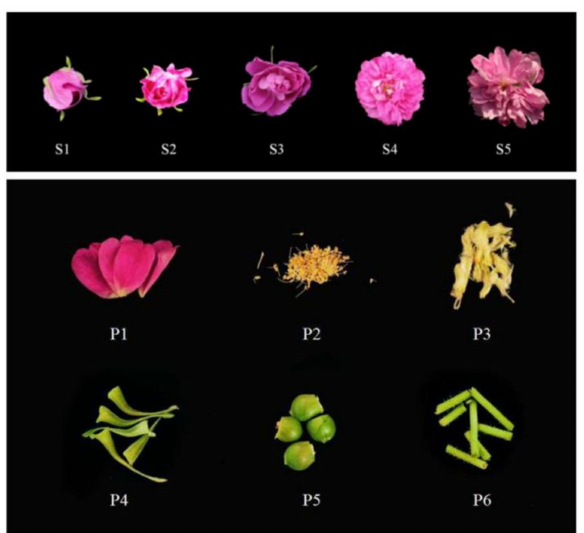
Figure 2. Different developmental stages and different parts of Rosa rugosa ‘Tanghong’